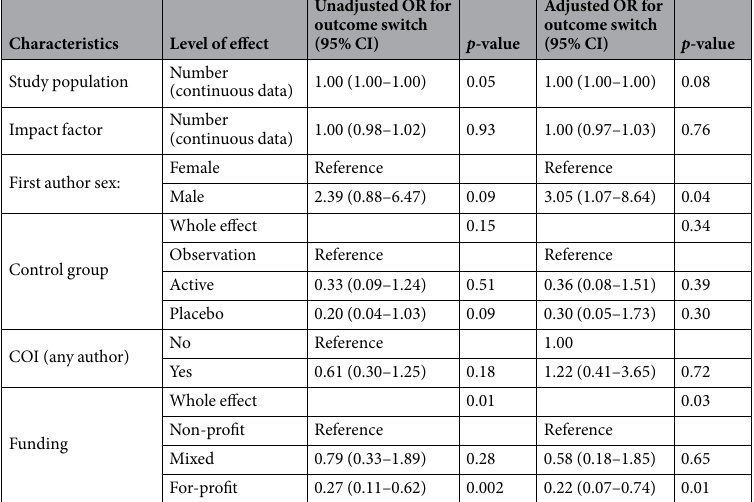
Table 3. Association of outcome switch and study characteristics, after univariable and multivariable adjustments (binomial logistic